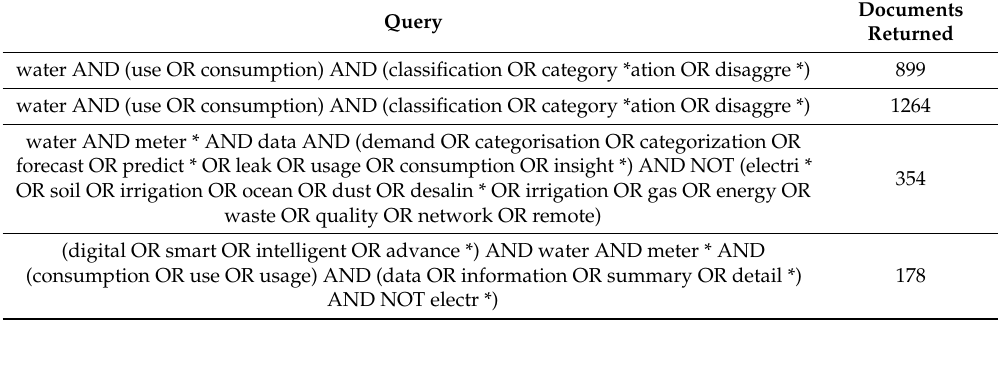
Table 1. Sample queries and their returned number of documents from the Scopus Database. Query